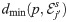
The calculation of the similarity measure BLD.First, the minimum “forward” distance dmin(p,Ej′s) between the point p∈Ejs and the contour Ej′s is determined, here marked as (1). Second, among all the points q on Ej′s with a “inverse” minimum distance dmin-1(q,Ejs), those are selected whose minimal distance is found at the point p. Here, q and q˜ are the candidates, with the corresponding distances denoted by (2) and (3). Then, the maximum distance among the candidates, in this case (2), is chosen as dmax-1(Ej′s,p). Finally, BLD(p,Ej′s) is defined as the maximum between dmin(p,Ej′s) and dmax-1(Ej′s,p), in this example (2). For more details see [30].